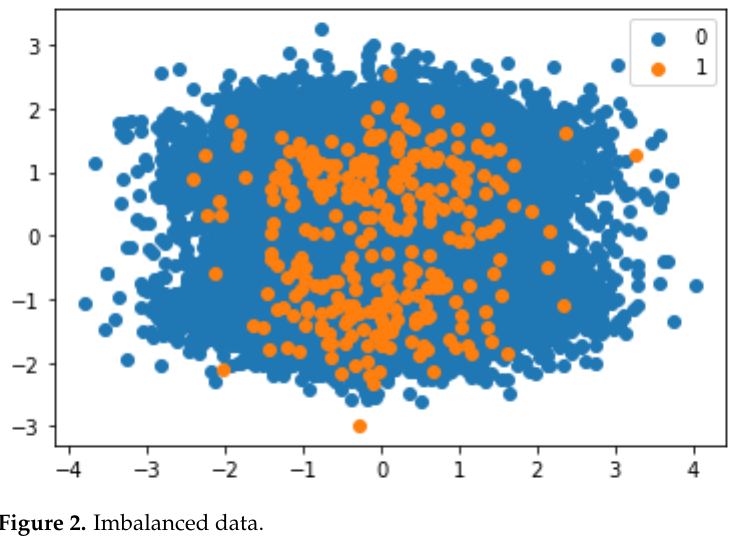
Figure 2. Imbalanced data.